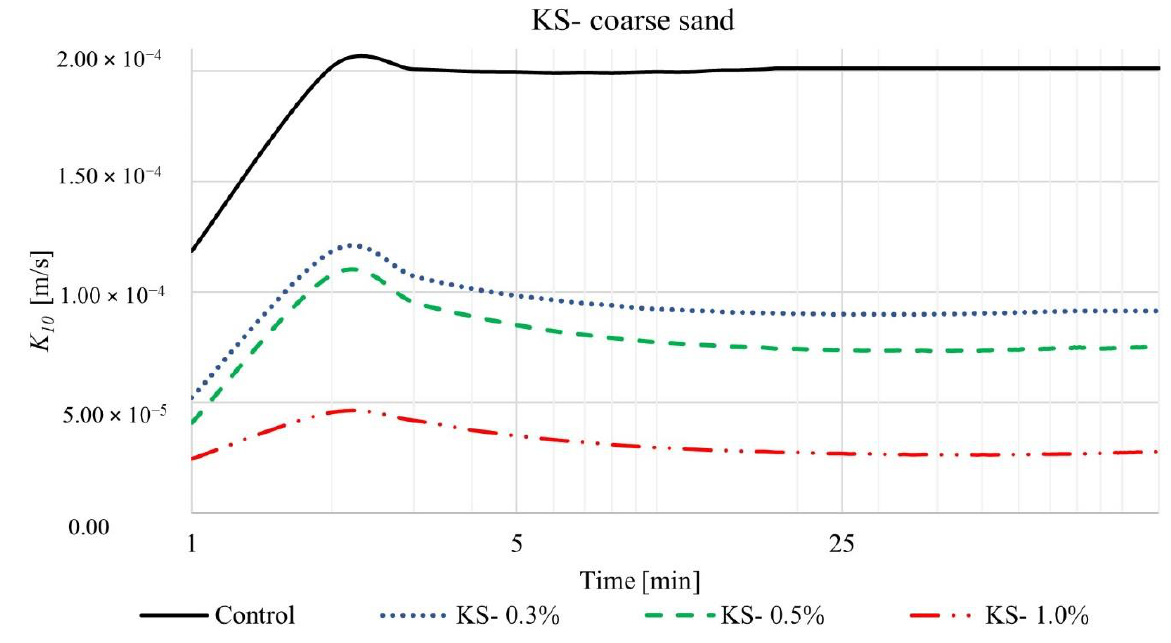
Figure 3. Time-dependent values of coefficient of permeability for SAP-KS and coarse sand mixtures, in proportions of 0.3, 0.5, and 1.0%.